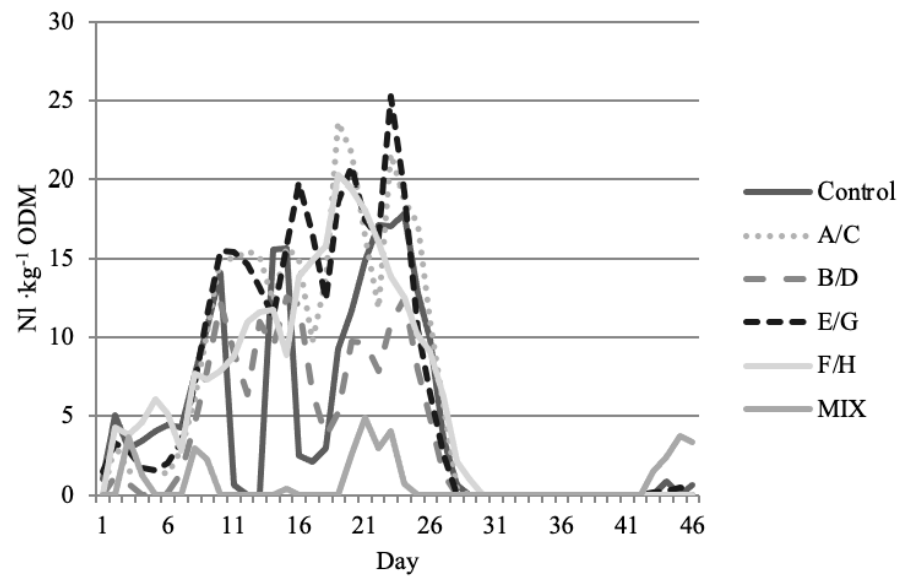
Figure 3. Daily amount of biogas produced in the methane fermentation of tested materials.